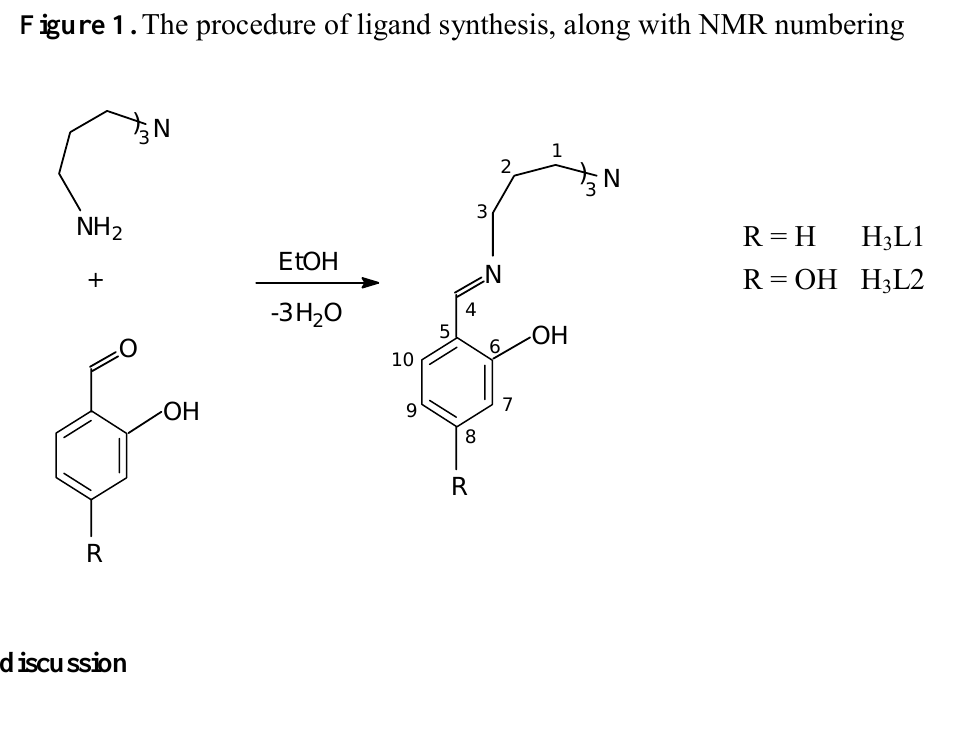
Figure 1. The procedure of ligand synthesis, along with NMR